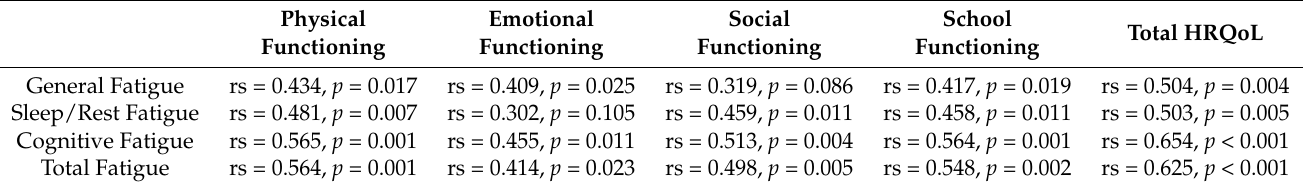
Table 3. Association between low fatigue (score ≤ 50) and health-related quality of life (HRQoL)